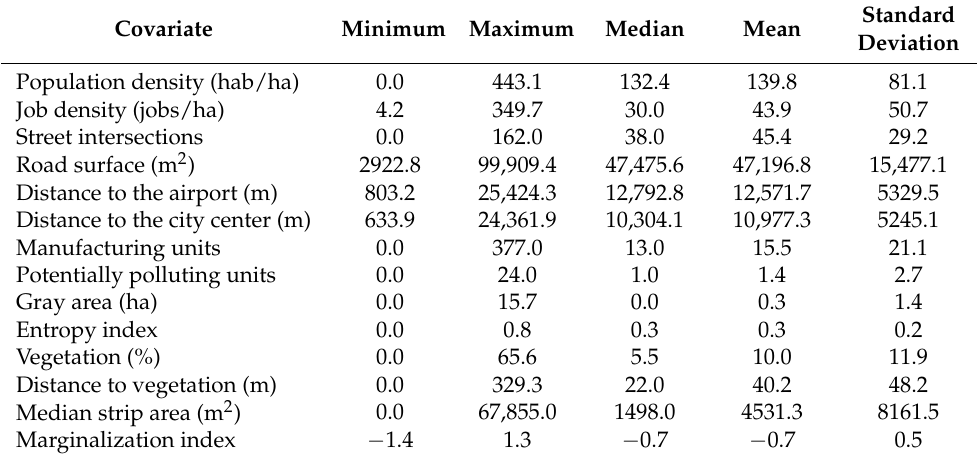
Table 2. Descriptive statistics of the covariates in the analysis. n =